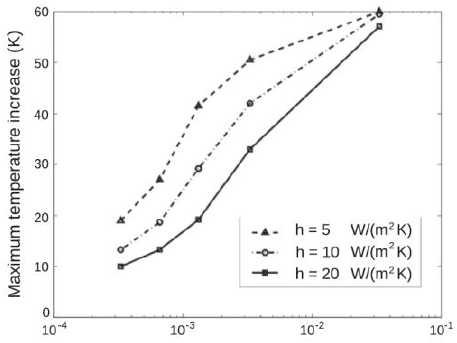
Figure 14. The maximum temperature increase under three different heat transfer coefficients (h) [51]. (Reprinted from Ref. [51], Fig. 11, 2012, with permission from Elsevier.)